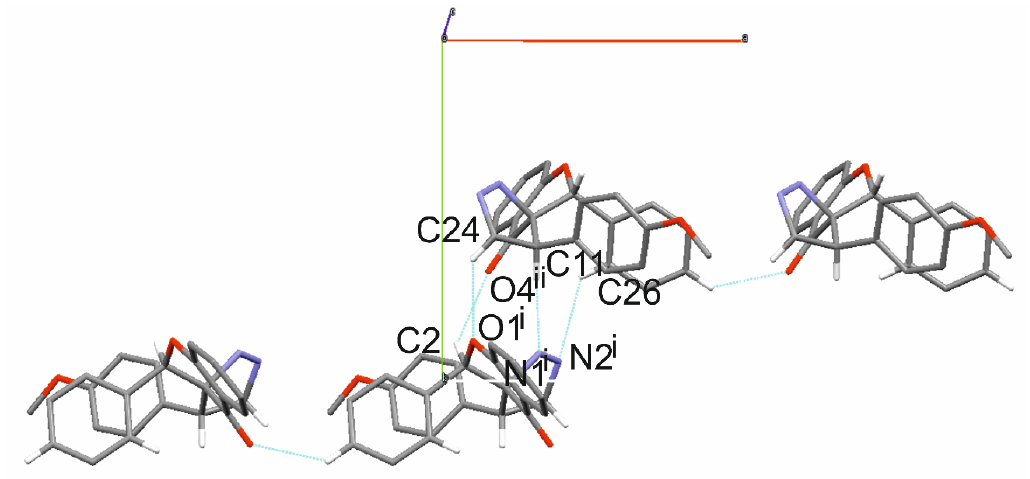
Figure 3. Partial molecular packing of 2 showing hydrogen-bonded dimers and chains.